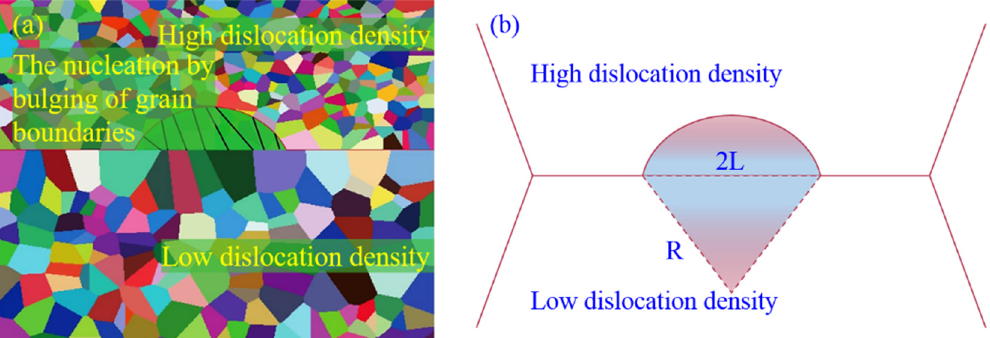
Figure 19. Schematic diagram of DDRXODF nucleation: ( a ) Nucleation by bulging of grain boundaries; ( b ) nucleation model [18,30].